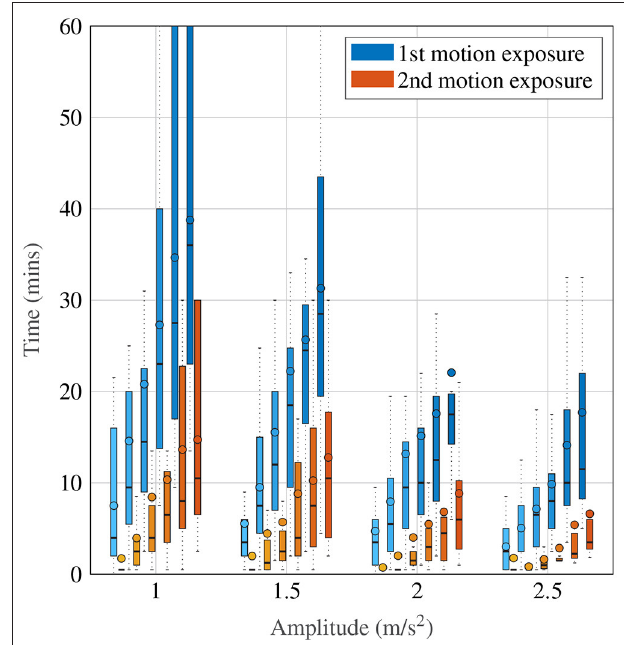
FIGURE 4 | Time to reach a certain MISC level as a function of amplitude during the first and the second motion exposures, given by the blue and orange-shaded bars, respectively. The darker shades correspond to increasing MISC levels.